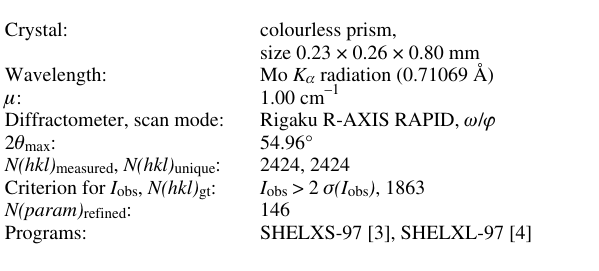
Table 1. Data collection and handling.